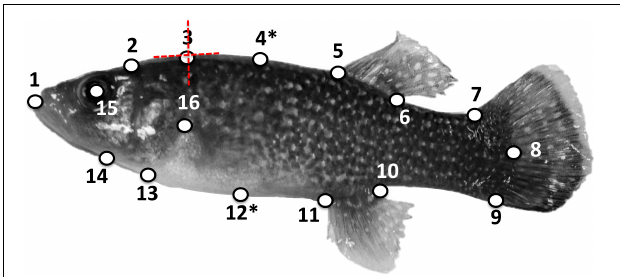
FIGURE 1 | Locations of 16 type II landmarks on a mature Fundulus grandis specimen as in Schaefer and Duvernell (2011), except for the removal of the second LM and shift of LM5 to the center of the eye. See text and Supplementary Material for details on the landmarks. Asterisks ( ∗ ) denote sliding LMs. Each LM was permitted to shift in the adaptive OU models in two dimensions as depicted for